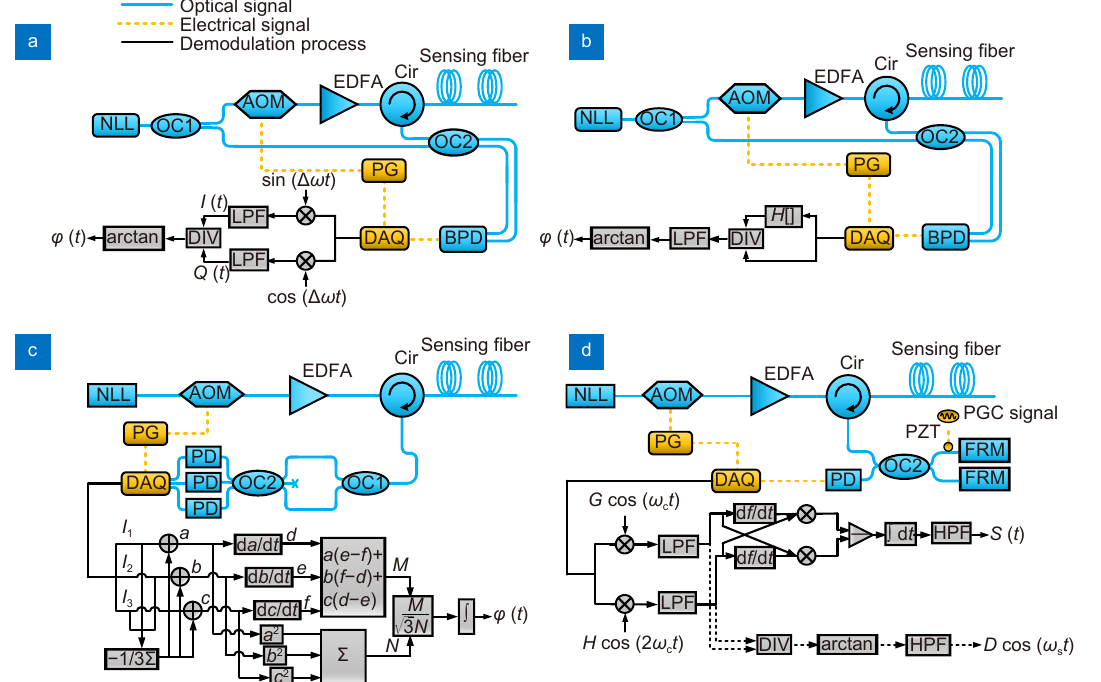
Fig. 2 | The setup of DAS-Φ-OTDR system with different demodulation methods. ( a ) Heterodyne detection + IQ phase demodulation. ( b ) Heterodyne detection + Hilbert transform phase demodulation. (c) Direct detection + phase demodulation based on a 3×3 coupler. ( d ) Direct de- tection + phase demodulation based on